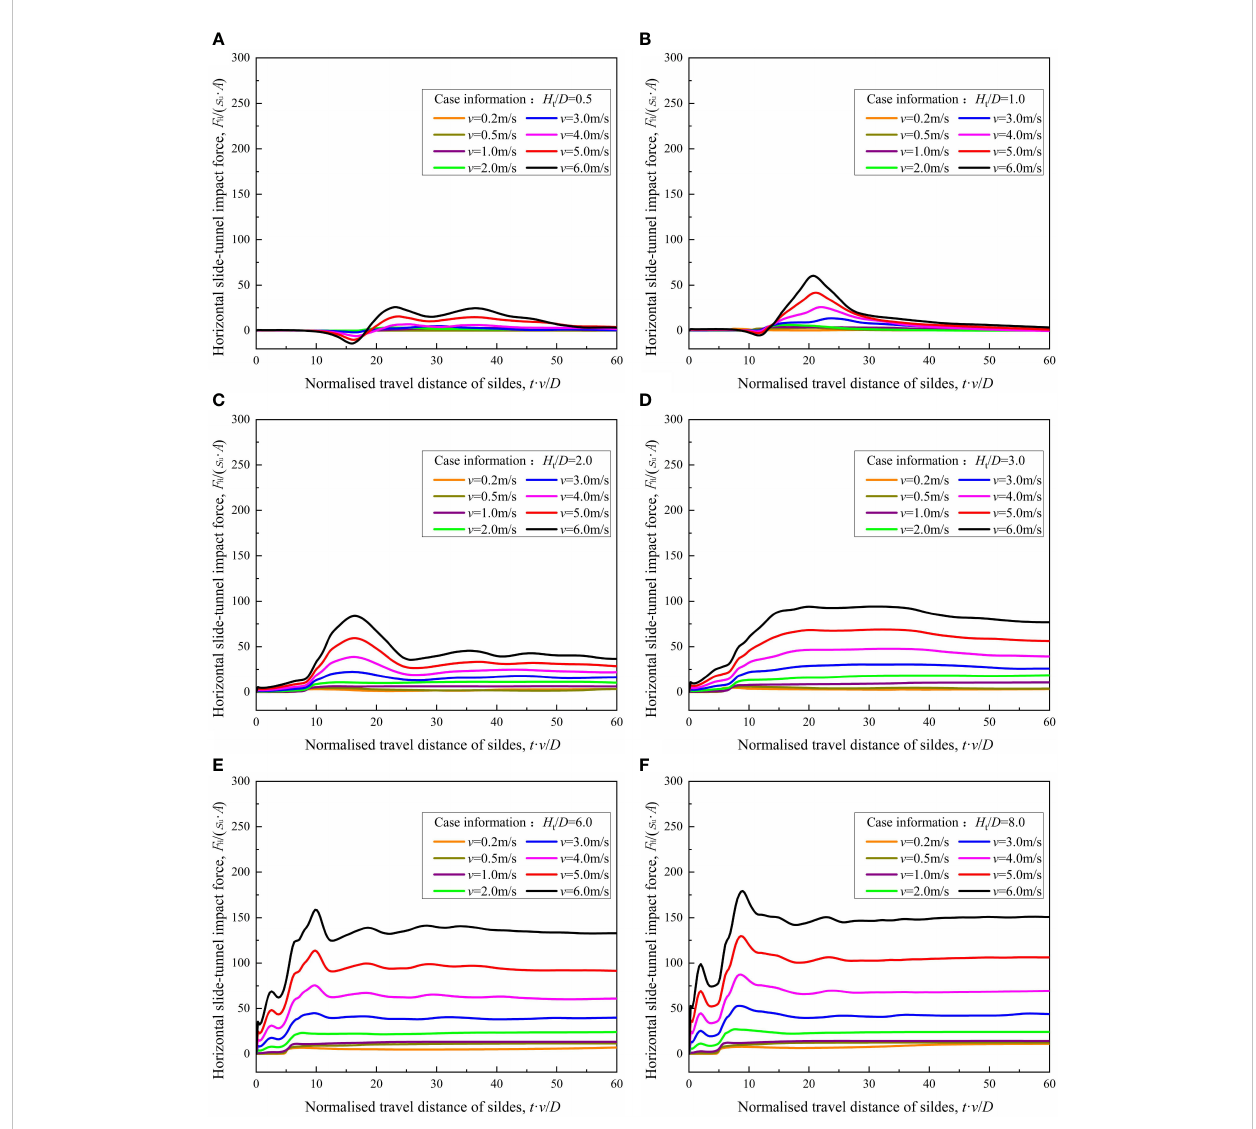
FIGURE 4 Horizontal impact force curves during submarine slide-tunnel interaction at different thicknesses of slide mass (an example of the octagon section). Ratios of slide mass thickness/diameter = 0.5 (A) , 1.0 (B) , 2.0 (C) , 3.0 (D) , 6.0 (E) , and 8.0 (F)